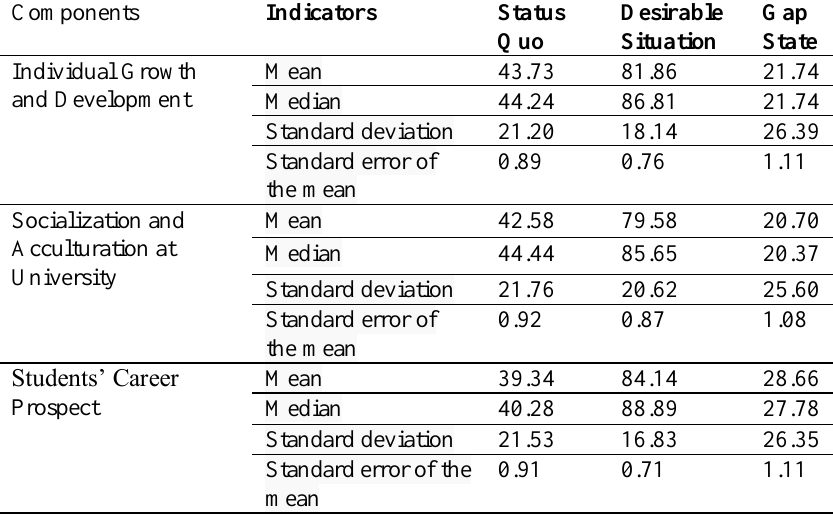
Characteristics of the dispersion of students' expectations of the status quo, the desirable status, and the gap